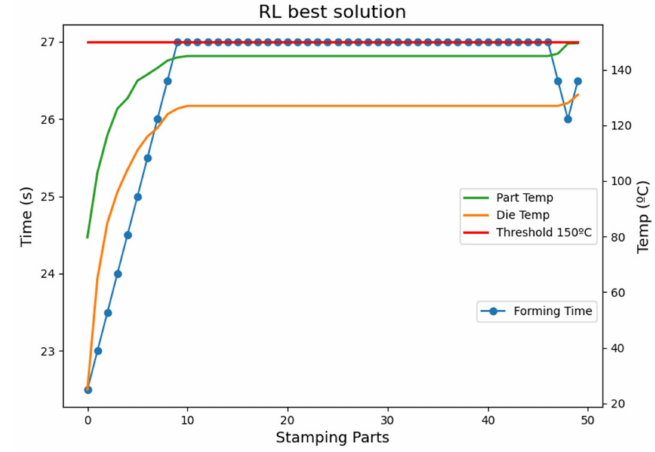
Figure 8. Batch execution with RL (Q-Learning) best solution.